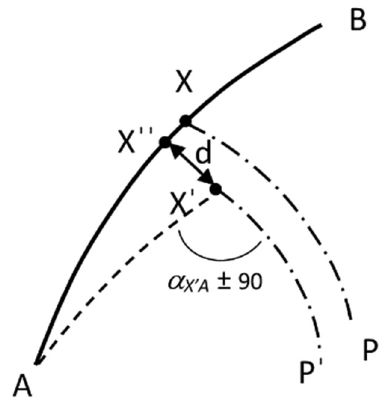
Figure 4. Distance deviations (X (cid:48) X” and